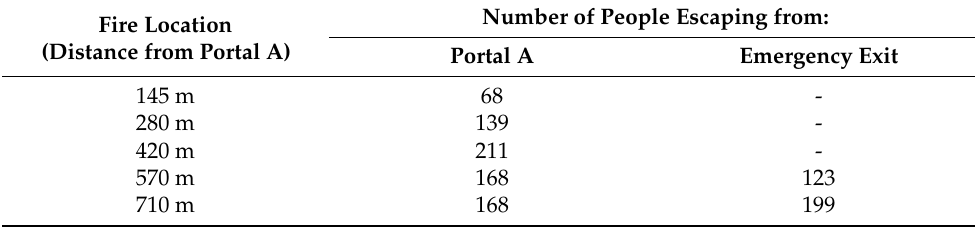
Table 3. Number of people escaping from portal A and emergency